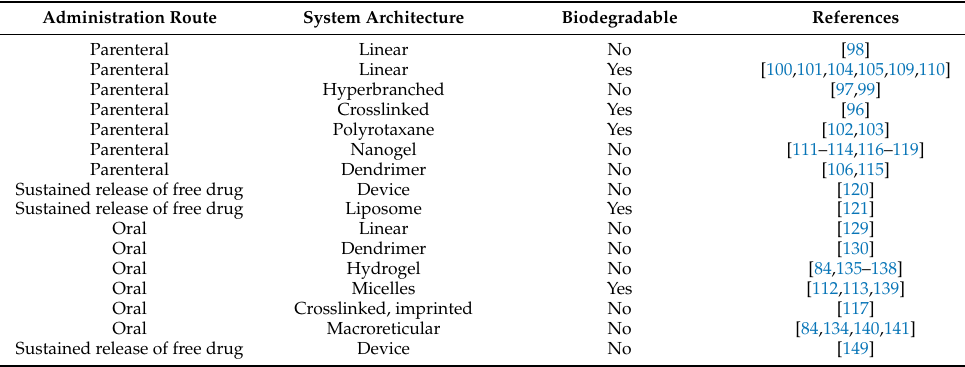
Table 2. Summary of polymer chelator